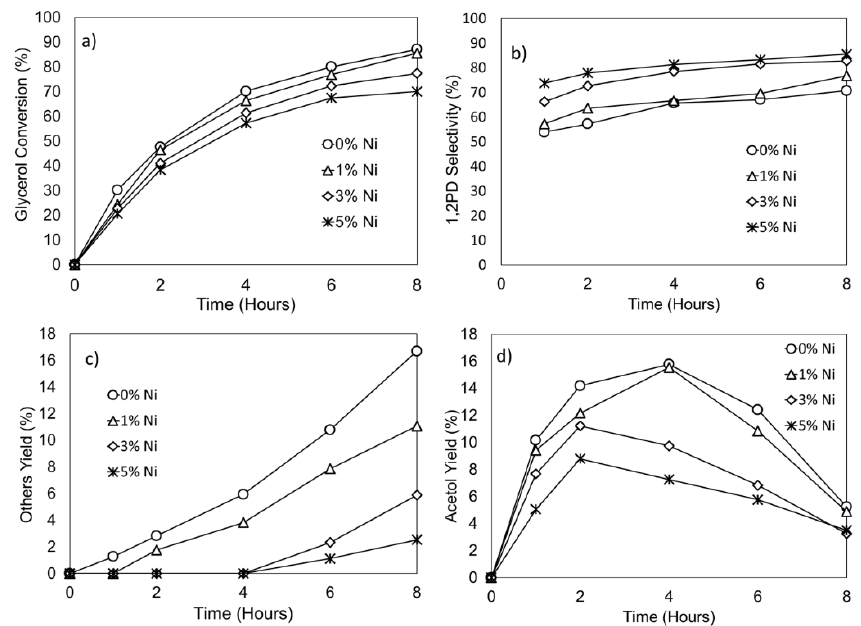
Figure 9. Effect of Ni molar contents on: ( a ) glycerol conversion; ( b ) 1,2-propanediol (1,2-PD) selectivity; ( c ) others yield; ( d ) acetol yield. Conditions: 220 °C, 1.5 MPa N 2 , 100 g feedstock mixture, 20 wt% glycerol, 32.2 wt% of water and 47.8 wt% methanol (water/methanol molar ratio = 1.2), 3 g catalyst, 500 RPM. Catalysts: Ni/Cu/ZnO/Al 2 O 3 -OA with different Ni molar contents. 0% Ni: Cu/Zn/Al (molar) = 35/35/30; 1% Ni: Ni/Cu/Zn/Al (molar) = 1/34.5/34.5/30; 3% Ni: Ni/Cu/Zn/Al (molar) = 3/33.5/33.5/30; 5% Ni:Ni/Cu/Zn/Al (molar) = 5/32.5/32.5/30.